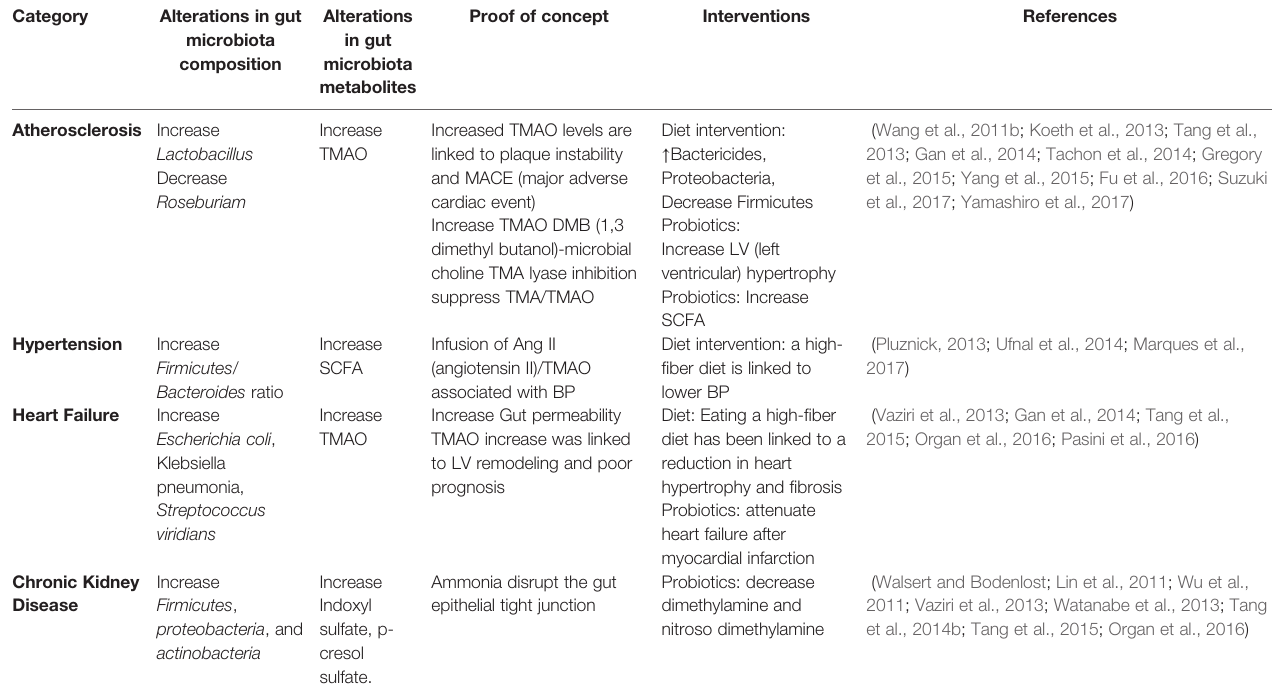
TABLE 4 | Pathogenic mechanism of gut microbiota and metabolites in cardiometabolic